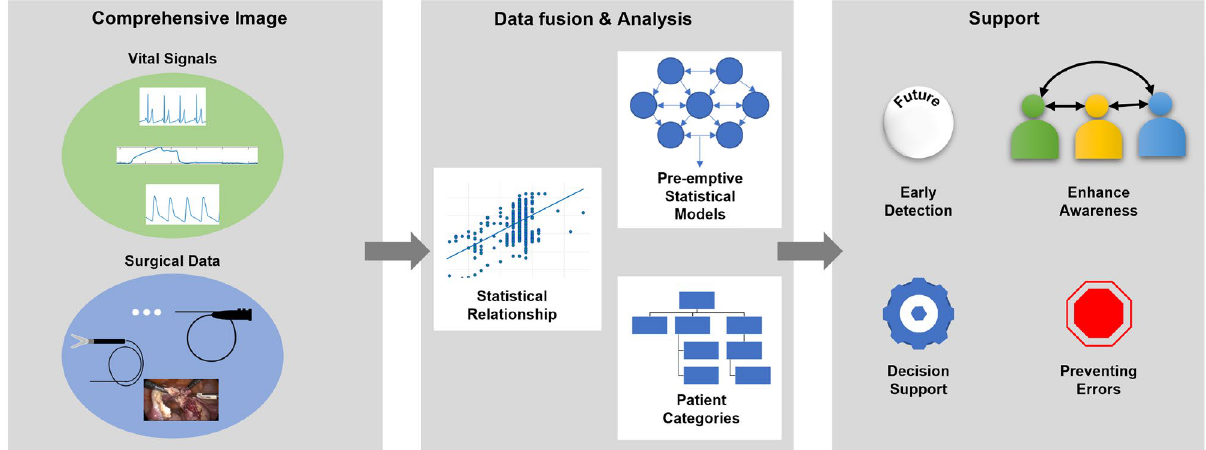
Figure 1. Schematic representation of a data-driven pipeline to establish a context-aware system inside the OR. Comprehensive Image: data from both the surgical and patient sides are combined. Data fusion and analysis techniques are employed to fuse data from different perspectives. Pre-emptive models are then developed to enhance surgical treatment by providing support to the medical staff (surgical and anaesthesiologic